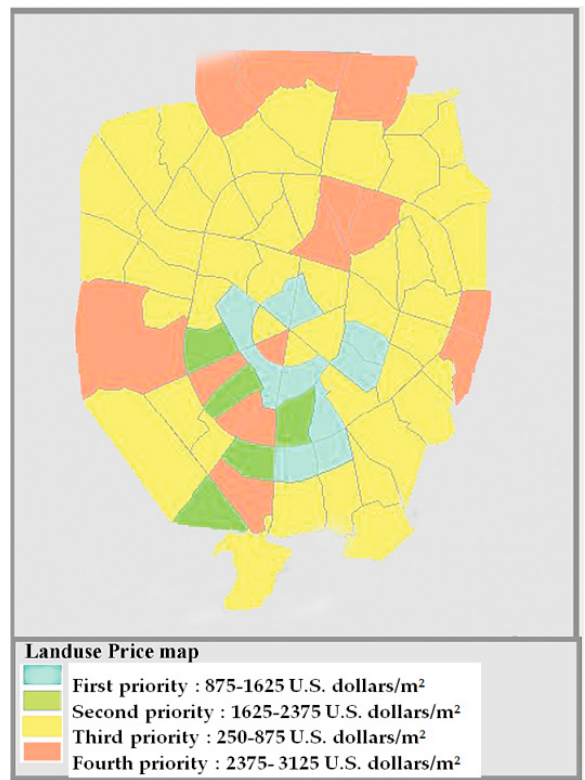
Figure 13. The land price map of Hamedan based on the sub-criteria measures in Table 1.